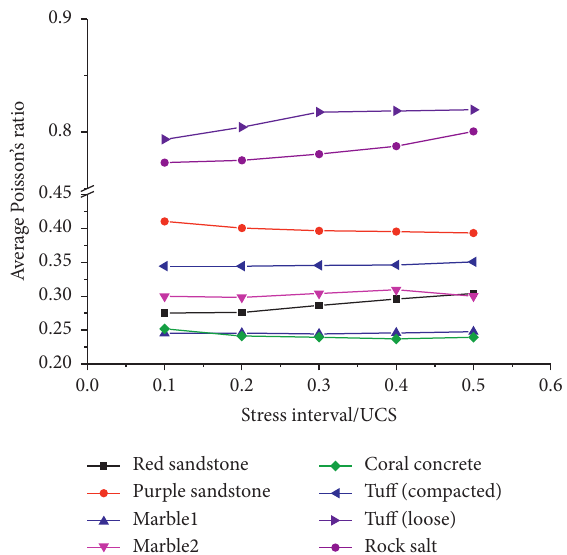
Figure 9: Average Poisson’s ratios calculated with different stress intervals (with the center point being fixed at 50% of